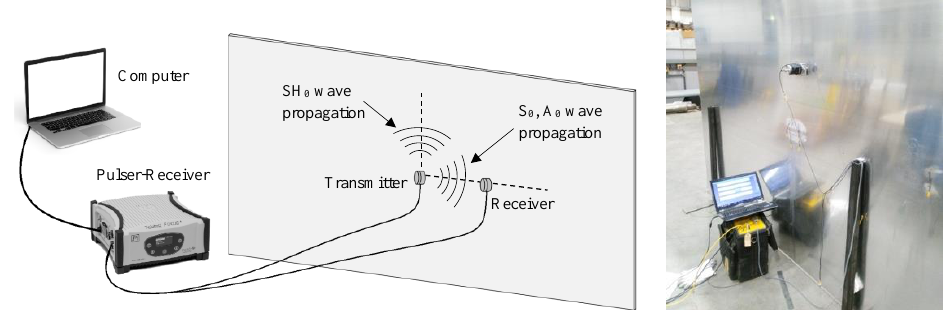
Figure 12. Experiment setup: Left –diagram of the experiment, Right –photo of the real experiment environment.